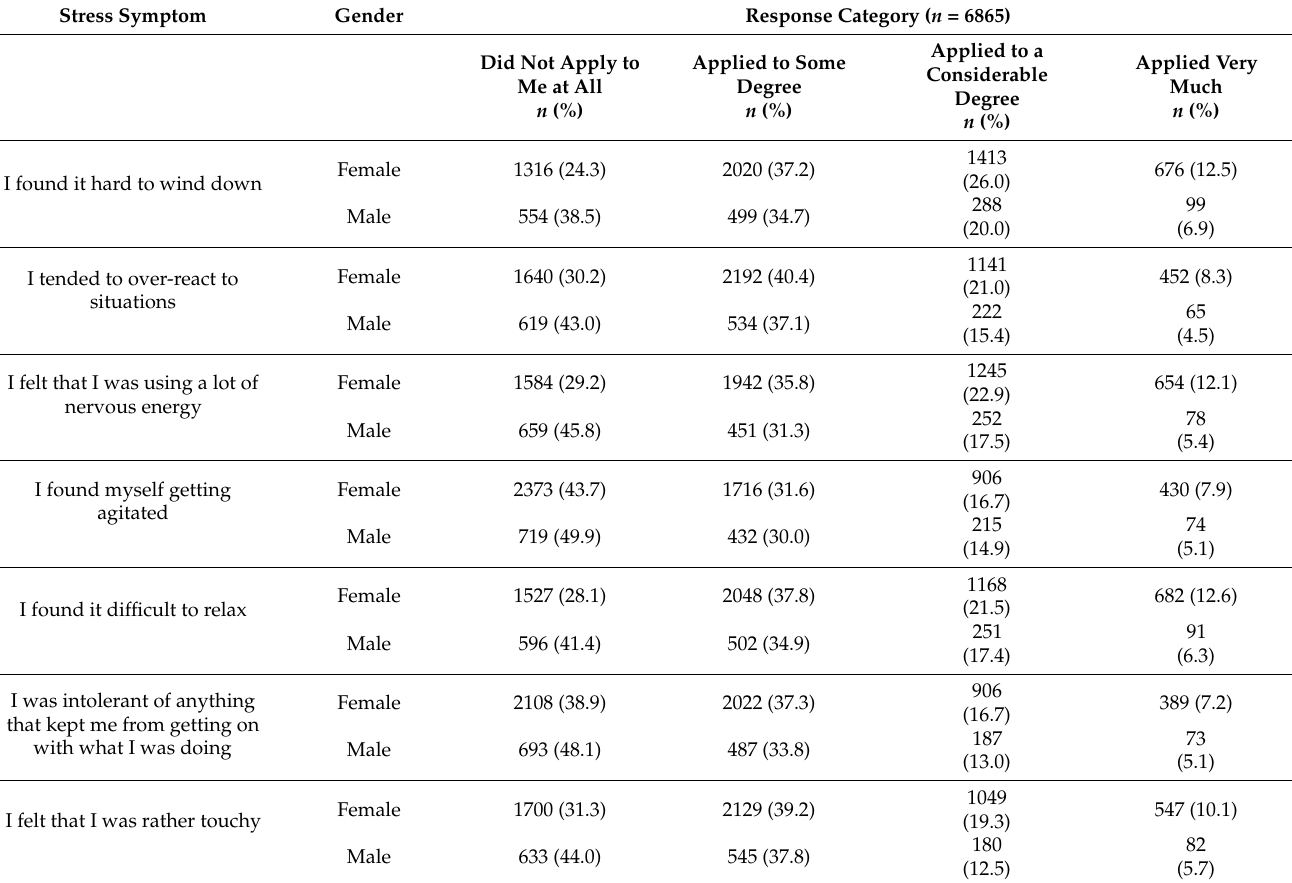
Table 2. Stress symptoms in men and women in the general population during